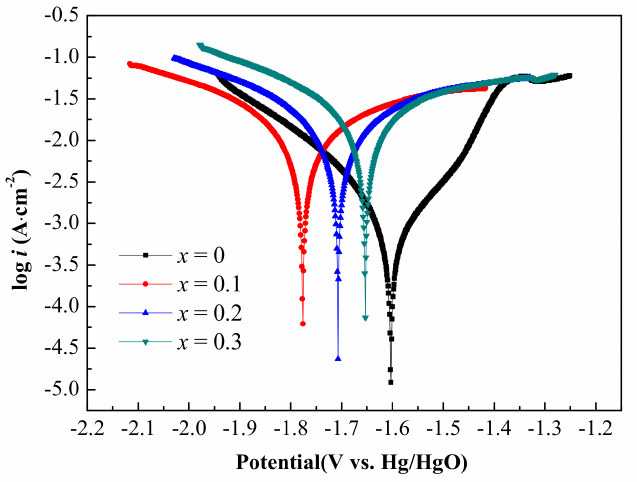
Figure 3. The potentiodynamic polarization curves of the Al-1Zn-0.1In-0.1Sn-0.5Mg-xMn (x = 0, 0.1, 0.2, 0.3) (wt.%) alloy anodes in the 4 M NaOH